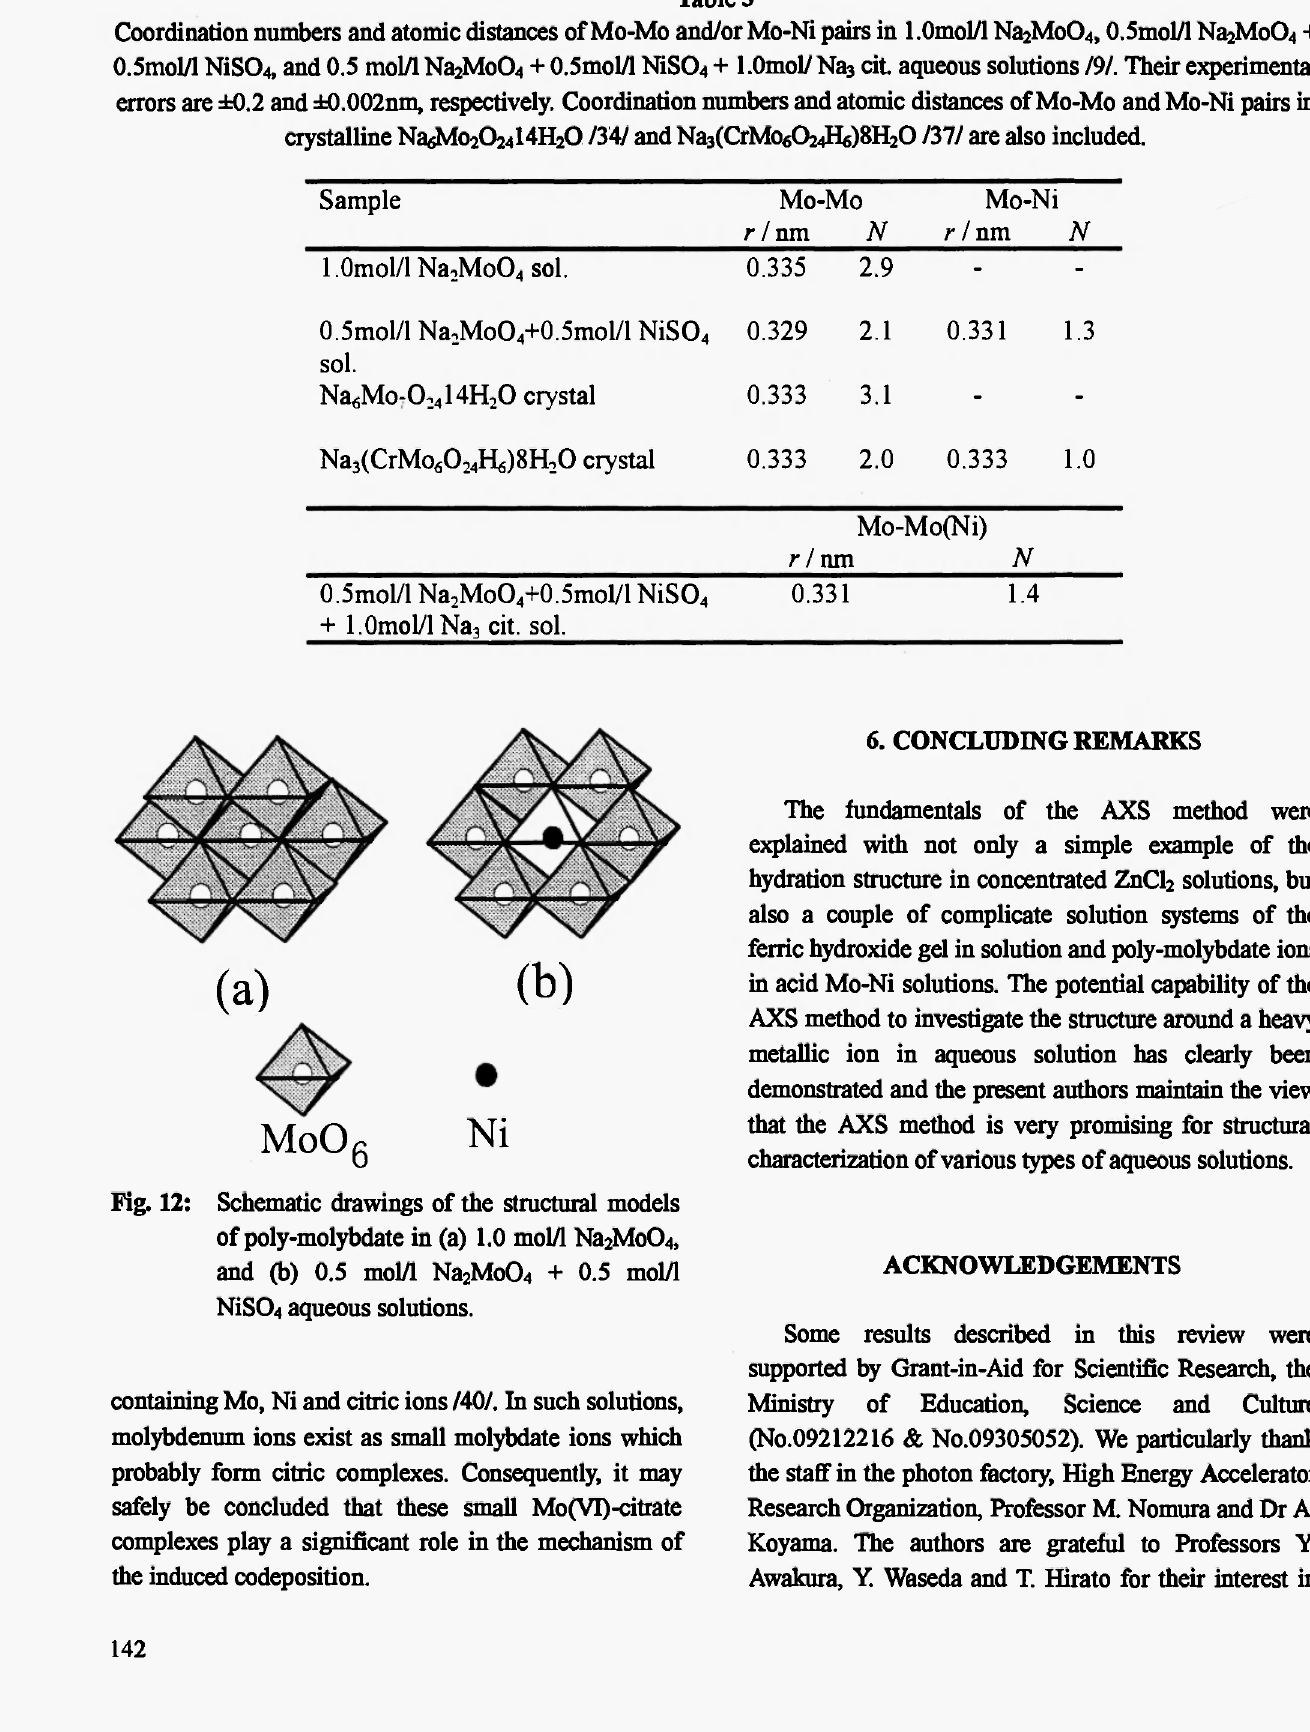
Mo0 ,0.5mol/l Na Mo0 + 2 4 2 4 Mo0 + 0.5mol/l NiS0 + l.Omol/ Na cit aqueous solutions 191. Their experimental 2 4 4 3